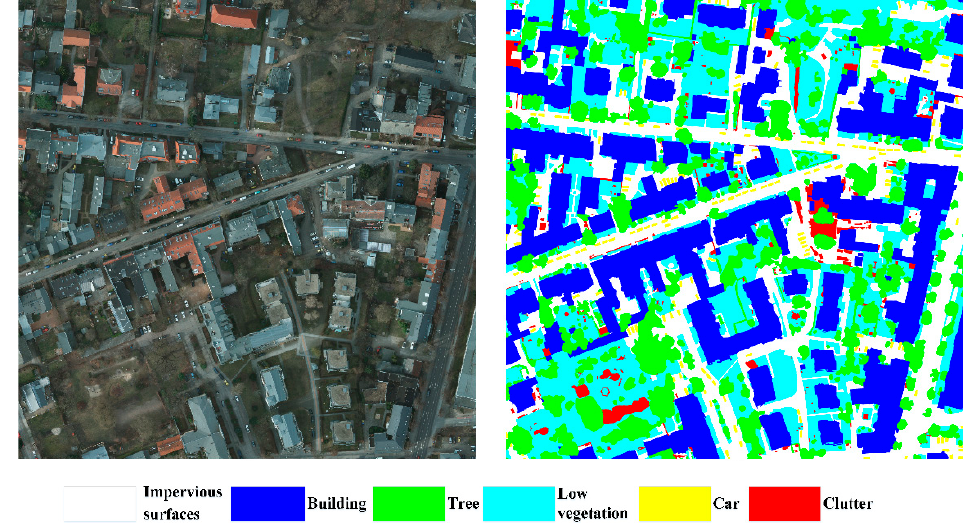
Figure 5. A Sample of the ISPRS Vaihingen Benchmark.